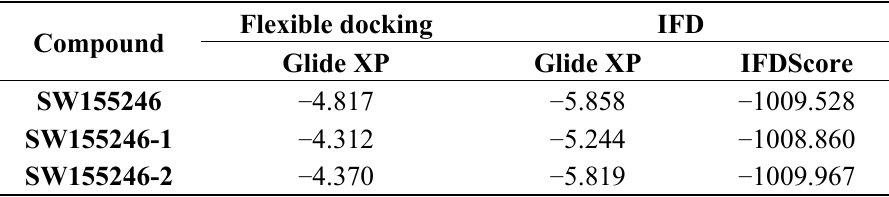
Table 1. Docking scores as computed with Glide XP using flexible docking and induced-fit docking (IFD). The IFD scores are also